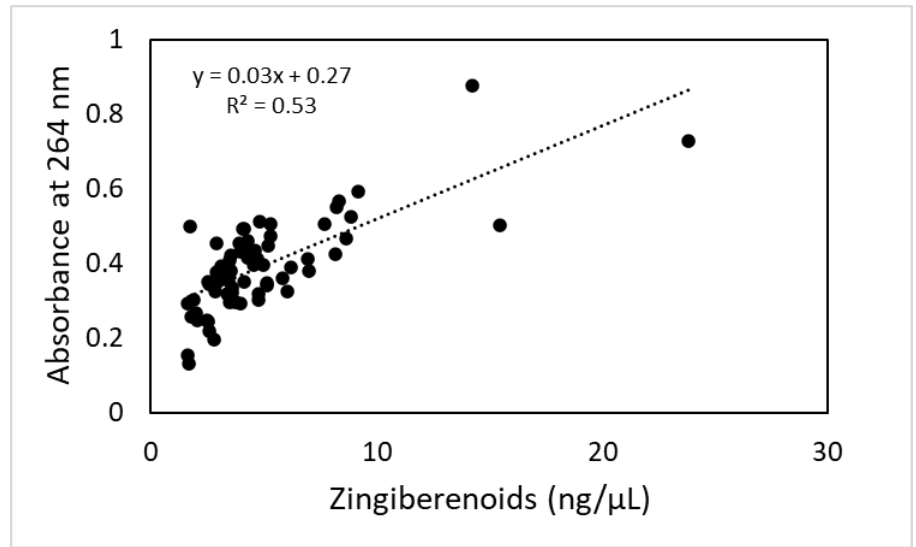
Figure 11. Relationship between absorbance at 264 nm and the zingiberenoid (7-epi zingiberene + 9-hydroxy zingiberene + 9-hydroxy, 10,11-epoxy zingiberene) content (ng/µL) determined by GC-FID of leaflet washes obtained from BC3F3 genotypes. Table 5. Results of stepwise regression between zingiberene content as determined by GC-FID and absorbance values from 200 to 350 nm for the BC3F5 generation.